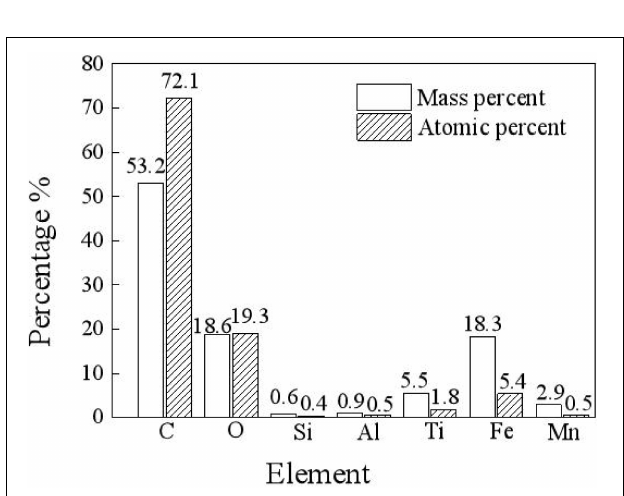
FIGURE 1 | Diagram of the microstructure of a carbon deposit. (A) Low-rate observation. (B) 100 × . (C) 300 × . (D) High-rate observation.